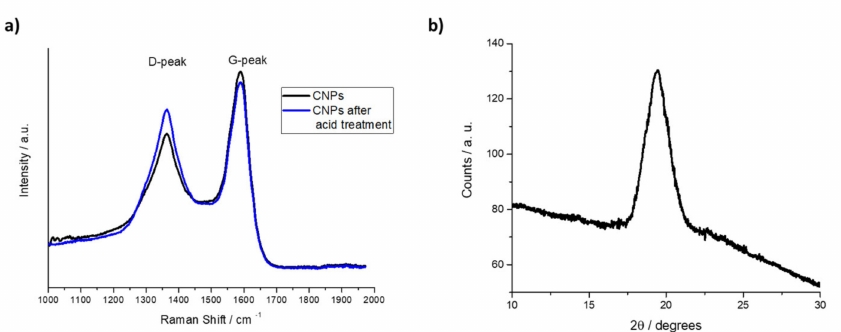
Figure 2. ( a ) Raman spectra of as-synthetized CNPs and after 1 h acid treatment at pH 4.5 ( b ) XRD spectrum of as synthetized